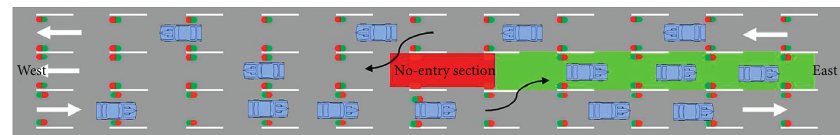
Figure 3: Configuration of starting conflict zone.